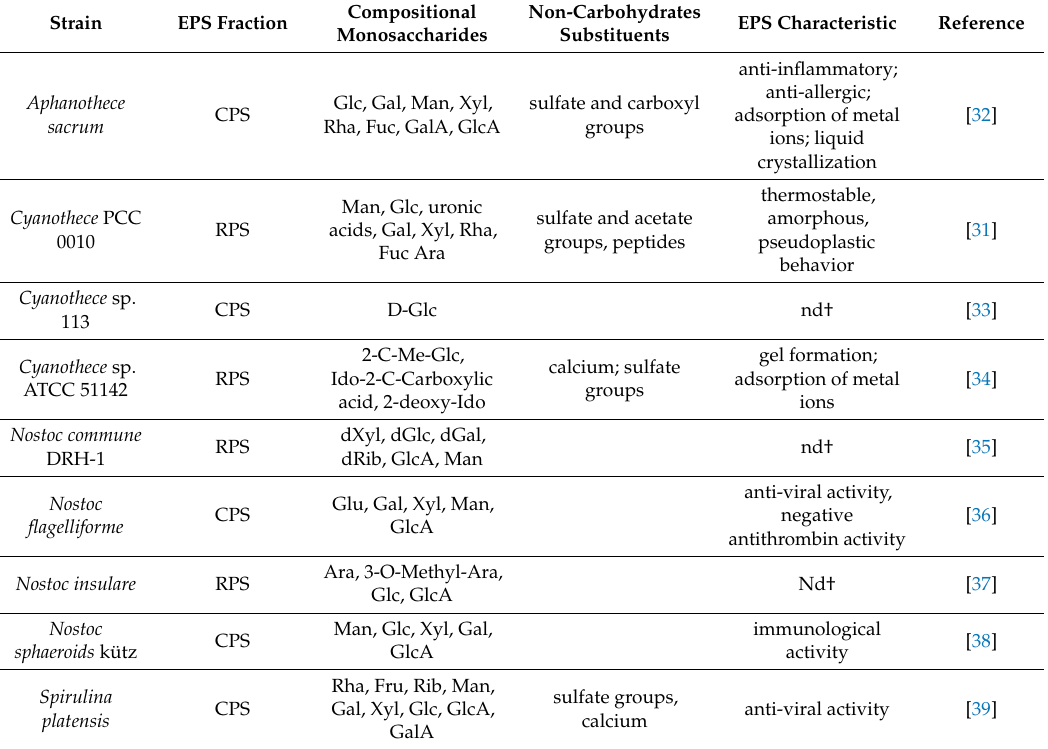
Table 1. Isolated exopolysaccharides (EPS) from